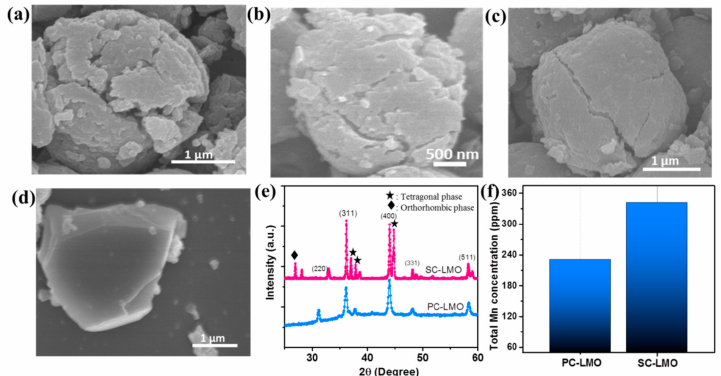
Figure 4. Post-cycling structural characterizations of single-crystal LiMn 2 O 4 and polycrystalline LiMn 2 O 4 cathodes. SEM images of ( a – c ) polycrystalline LiMn 2 O 4 and ( d ) single-crystal LiMn 2 O 4 cathodes after 10 cycles. ( e ) XRD patterns and ( f ) detected Mn(II) ion concentrations in electrolyte of polycrystalline LiMn 2 O 4 and single-crystal LiMn 2 O 4 cathodes after 10